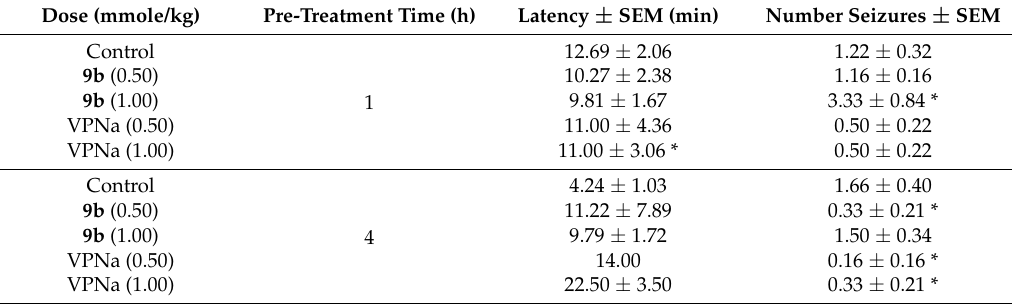
Figure 6. Tonic-clonic seizures number elicited by compound 9b compared to VPNa at different doses (0.5 and 1.00 mmole/kg) at 1 h and 4h of pretreatment. * p < 0.05: Significant difference comparing control group with 9b and VPNa as positive control group. Comparisons were made by the one-way ANOVA test and Duncan’s means analysis test [52–54]. Table 5. Parameters of anticonvulsive activity of compounds 9b and VPNa on the PTZ-induced seizures model. * p <